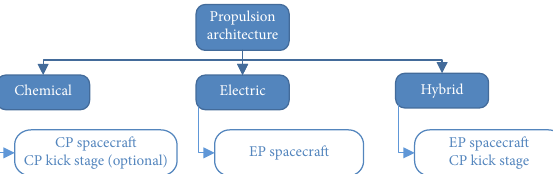
Figure 3: An overview of the propulsion architecture options considered for